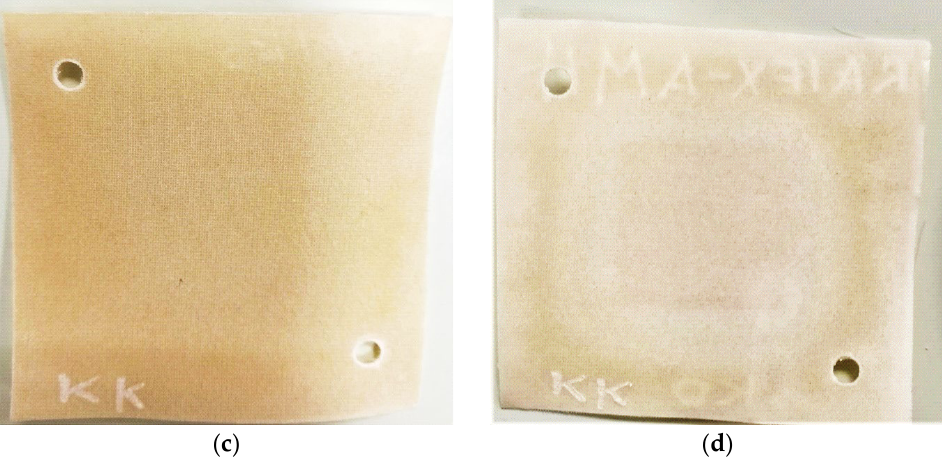
Figure 9. Photographs of the surfaces of MA-41P ( a ), MA-41Pmod ( b ), Ralex AMH-PES ( c ), and Ralex AMH-PESmod ( d ) anion-exchange membranes, facing the concentration chamber, after their operation in the artificial solution.